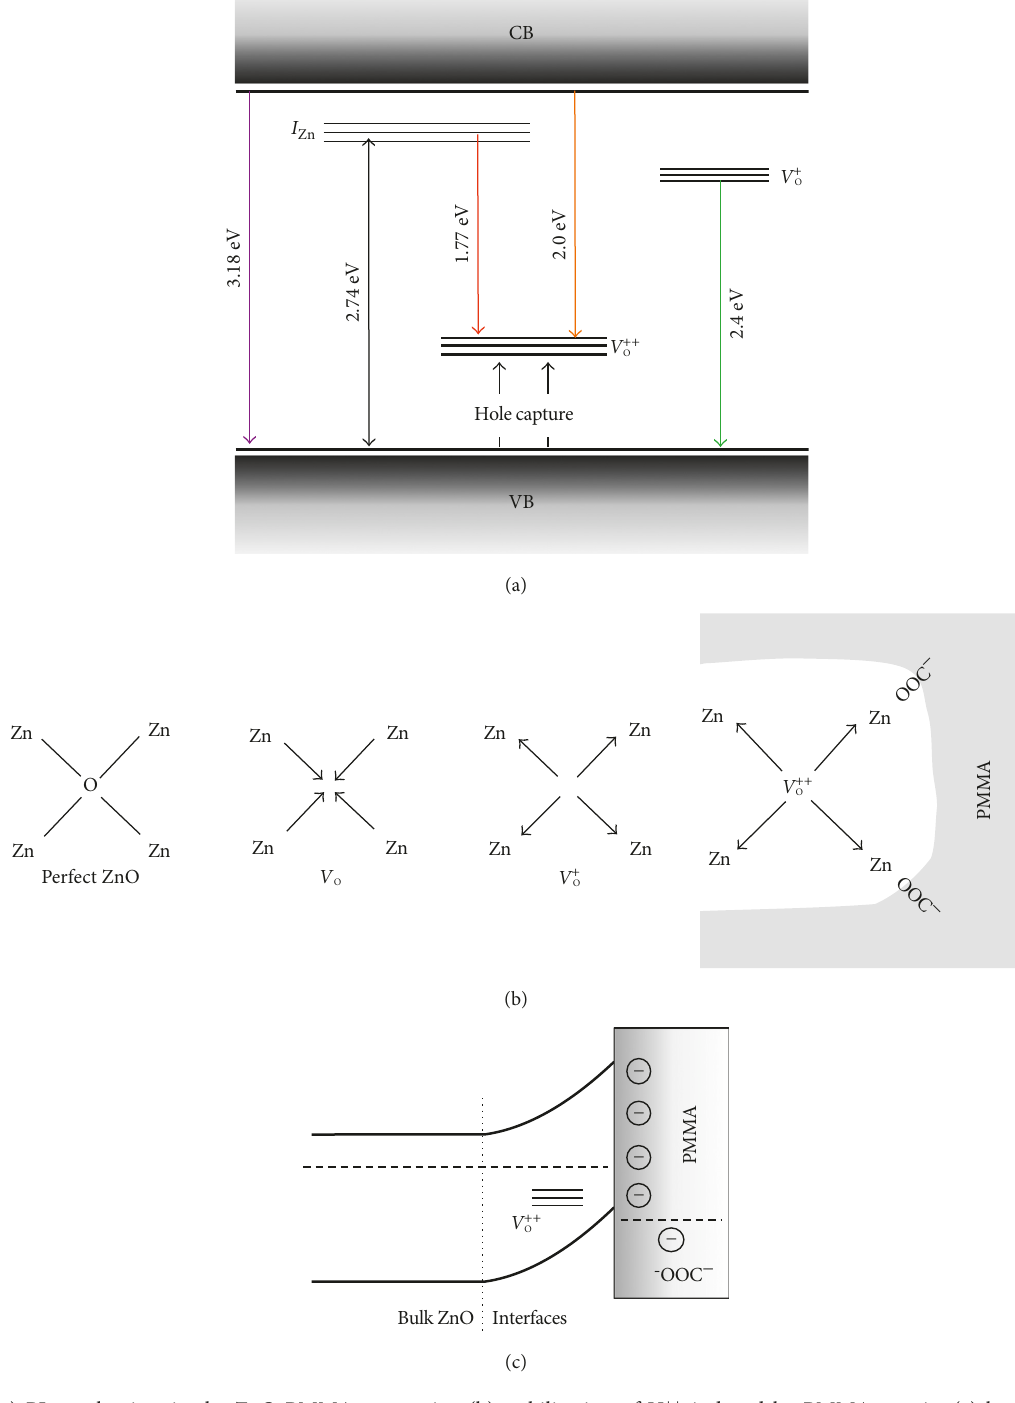
O induced by PMMA matrix; (c) band bending at